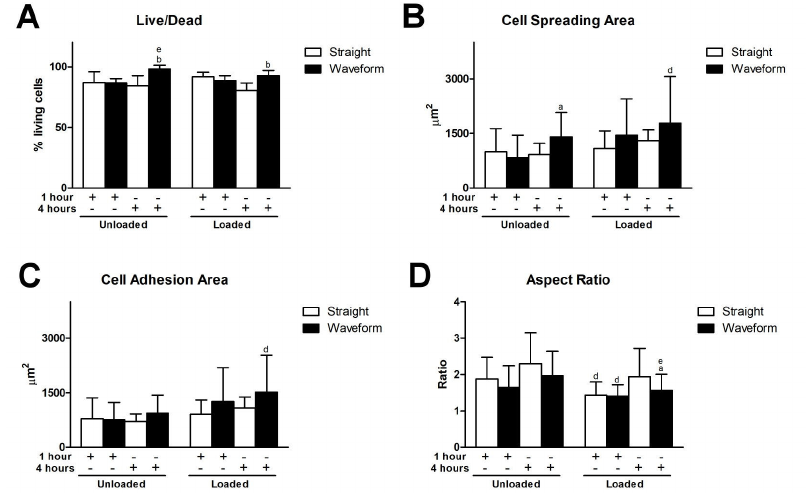
Figure 5. Behaviors of PDL cells on the microfibers. ( A ) The ratio of living cells. ( B ) Cell spreading area. ( C ) Cell adhesion area. ( D ) Aspect ratio. (Significant difference to the straight microfibers under the same loading condition at the same time point: a = p < 0.05, b = p < 0.01; significant difference to the straight microfibers without loading at the same time point: d = p < 0.05, e = p <